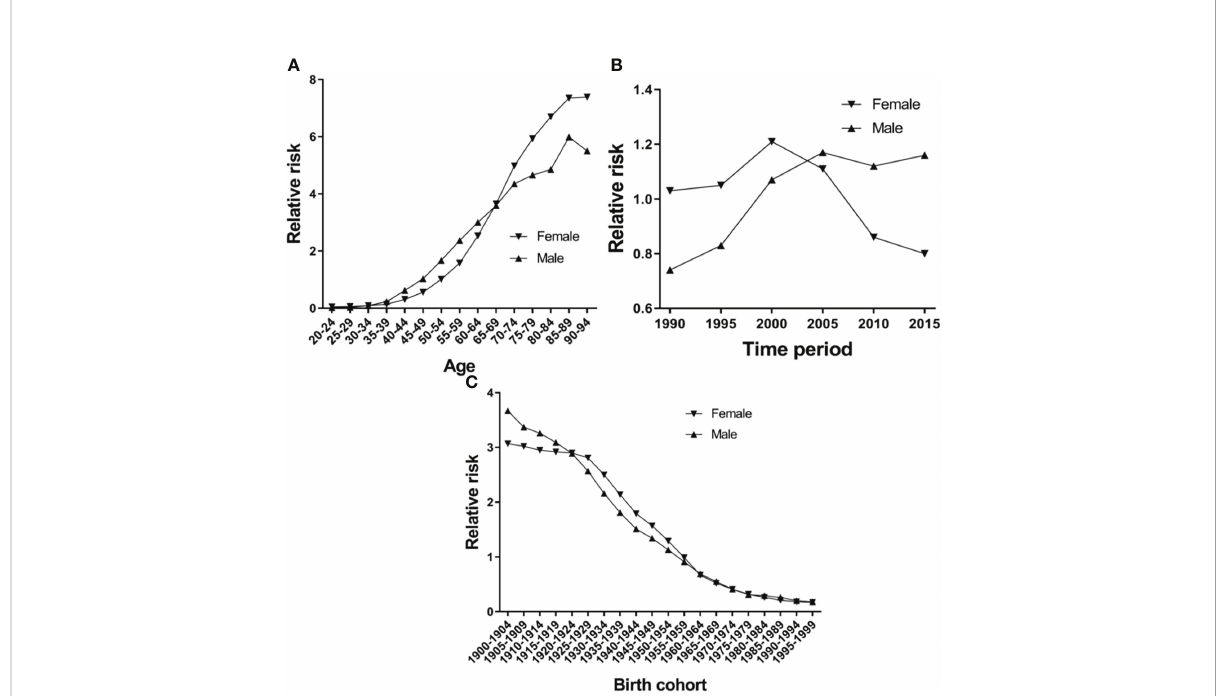
FIGURE 6 Esophageal cancer mortality relative risk due to (A) age; (B) period; and (C) birth by using age-period-birth model analysis with the intrinsic estimator